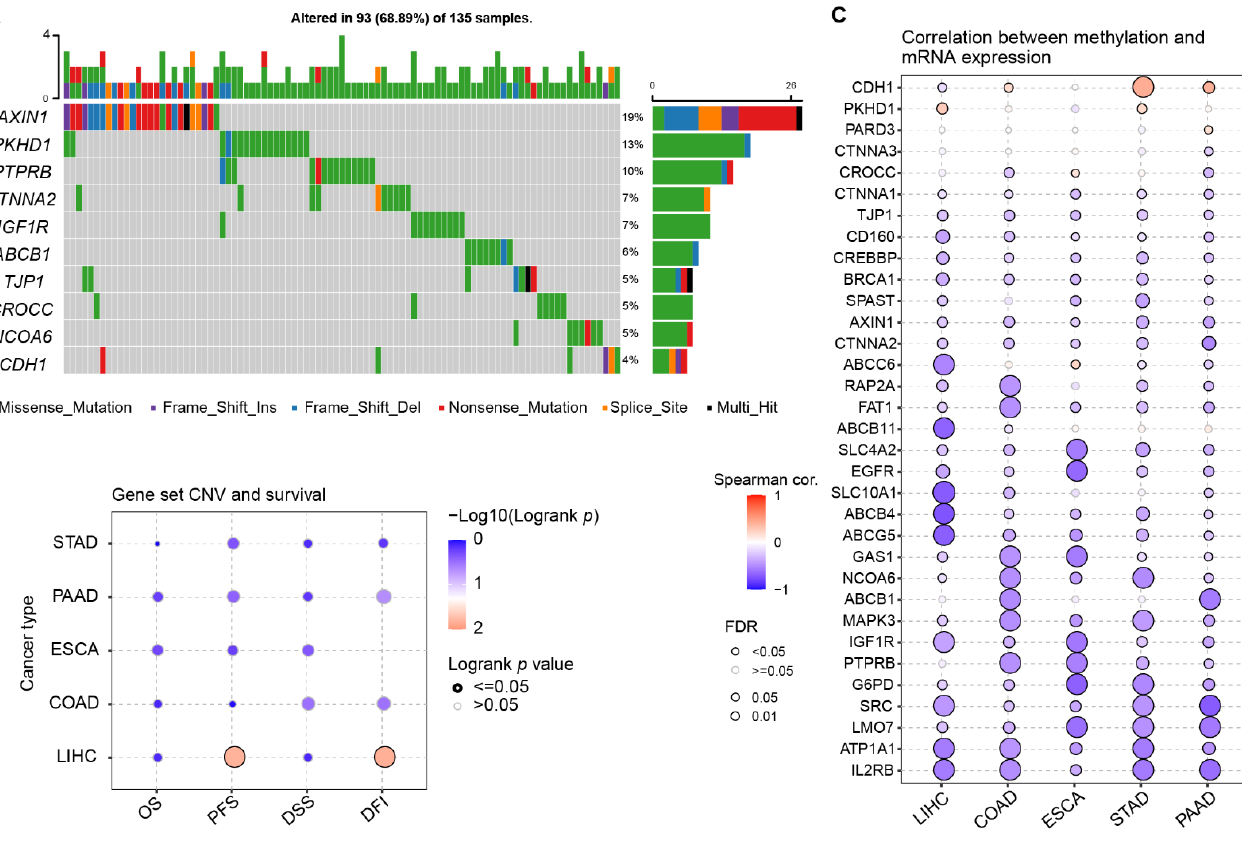
Figure 4. Mutation analysis of the selected PRGs with clinical value in LIHC and other digestive system cancers. ( A ) Single nucleotide variants (SNV) of the top 10 PRGs in LIHC. ( B ) Survival analysis of gene set copy number variants (CNV) across five digestive cancer types. ( C ) Correlation between methylation and mRNA expression of the selected PRGs.